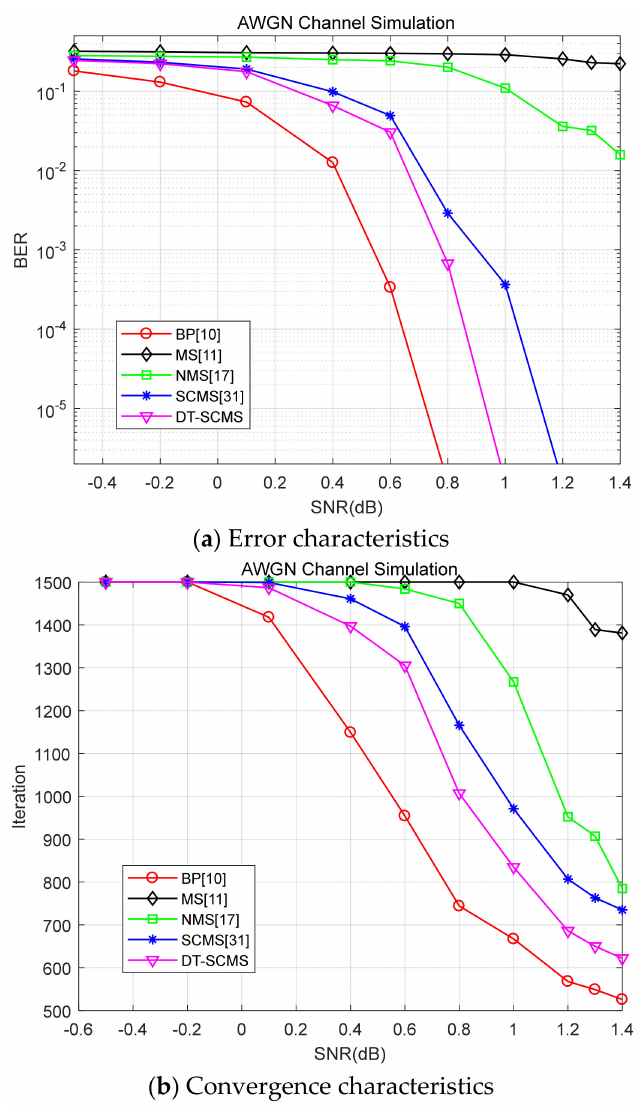
Figure 3. Simulations of belief propagation (BP), minimum sum (MS), normalized minimum sum (NMS), self-corrected minimum sum (SCMS), DT-SCMS, when R = 1 /